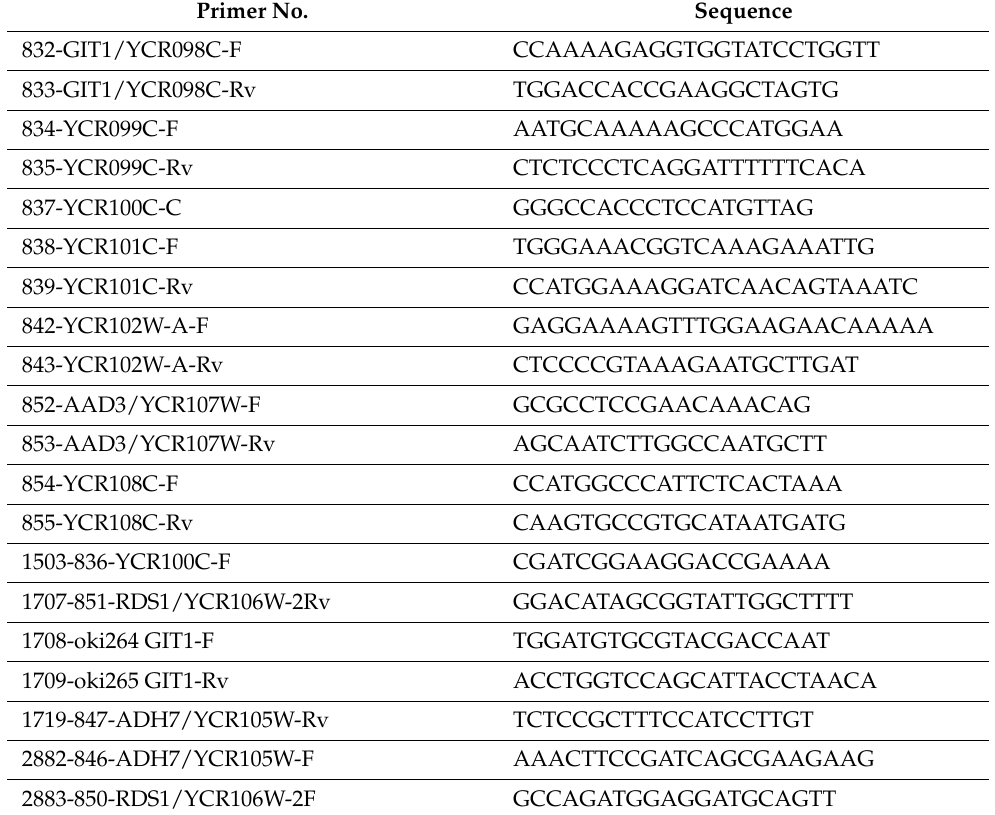
Table 2. Primer list for qPCR. Primer No.